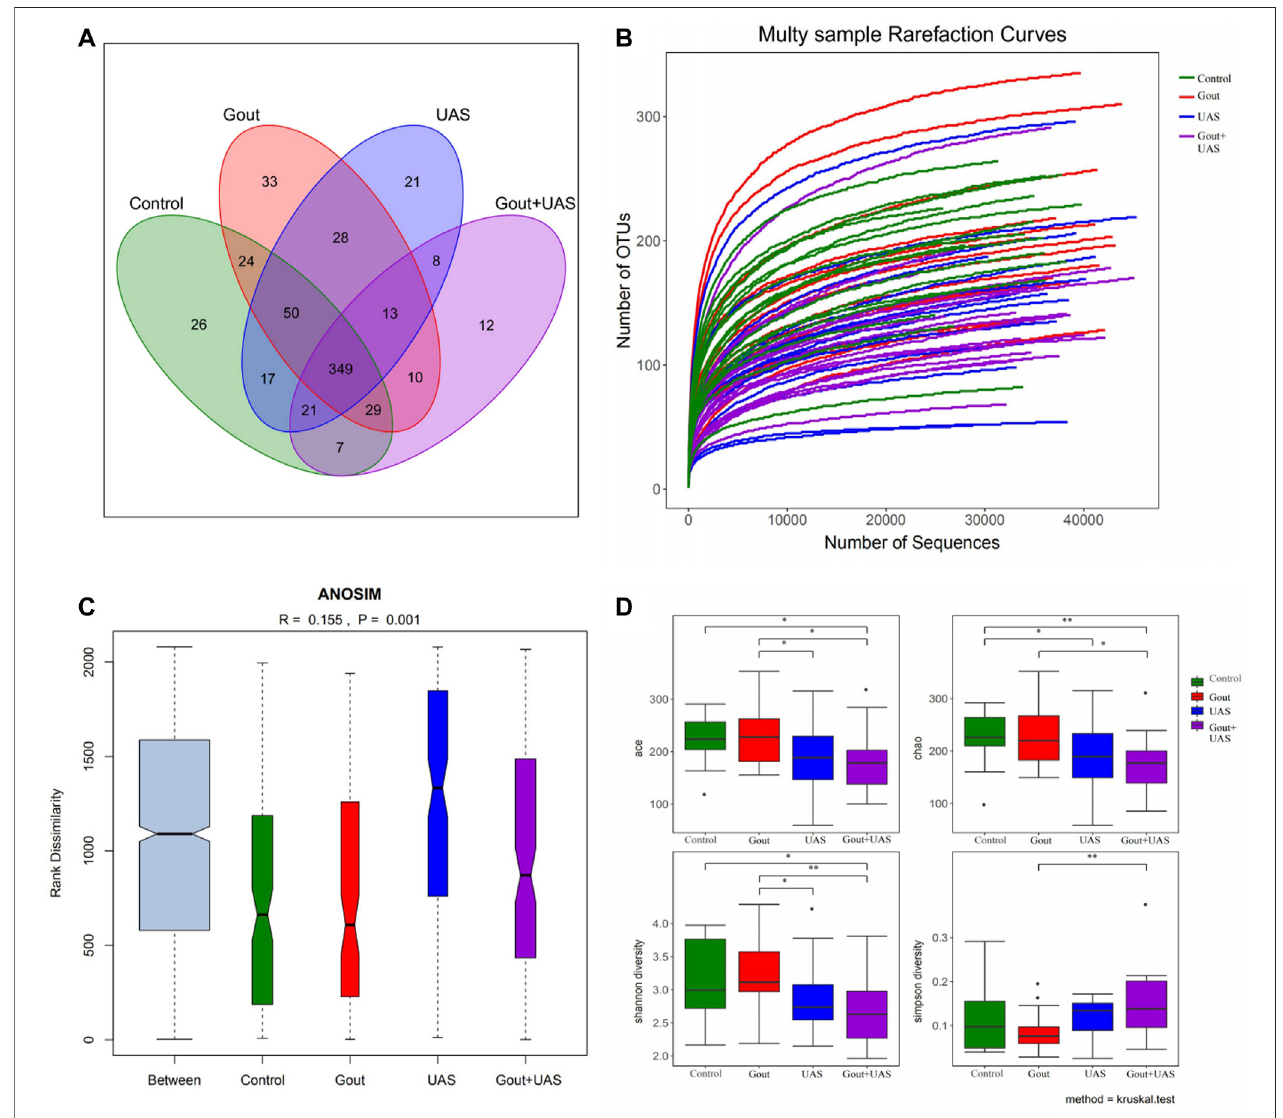
FIGURE 1 | Analysis of gut microbiota among each group by using 16s rRNA. (A) Venn diagram for indicating the common and unique OTUs among four groups. (B) Multi-sample rarefaction curves for comparing the abundance of diverse species in each sample. (C) ANOSIM analysis for identifying the existence of differences between each group. (D) Comparison of alpha diversity of gut microbiota between each group. The ACE, Chao, Shannon, and Simpson indices at the operational taxonomic units (OTUs) level were compared between each group by Kruskal – Wallis test (* p < 0.05** p < 0.01).